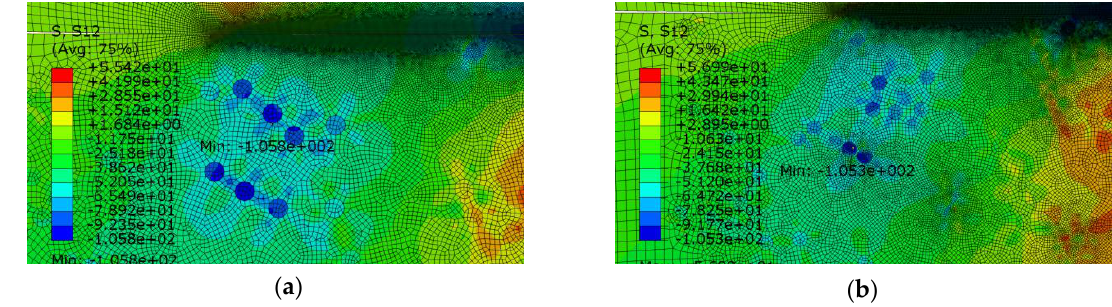
Figure 14. The local inclusion alignment of the shear stress peak for ( a ) case 3 and ( b ) case 4.